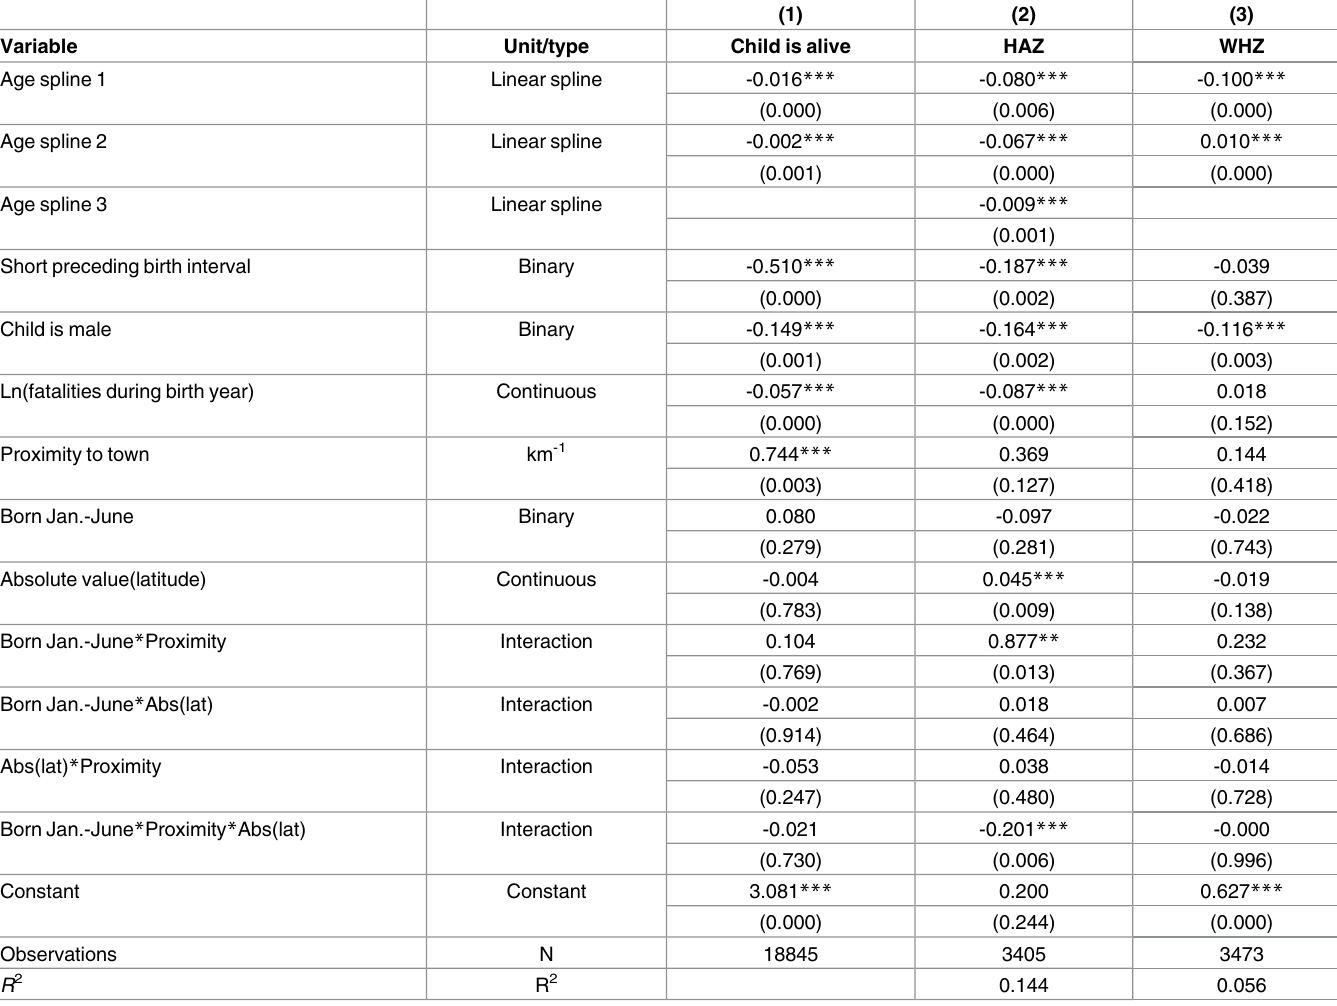
Table 5. Triple difference-in-differences results for the pooled